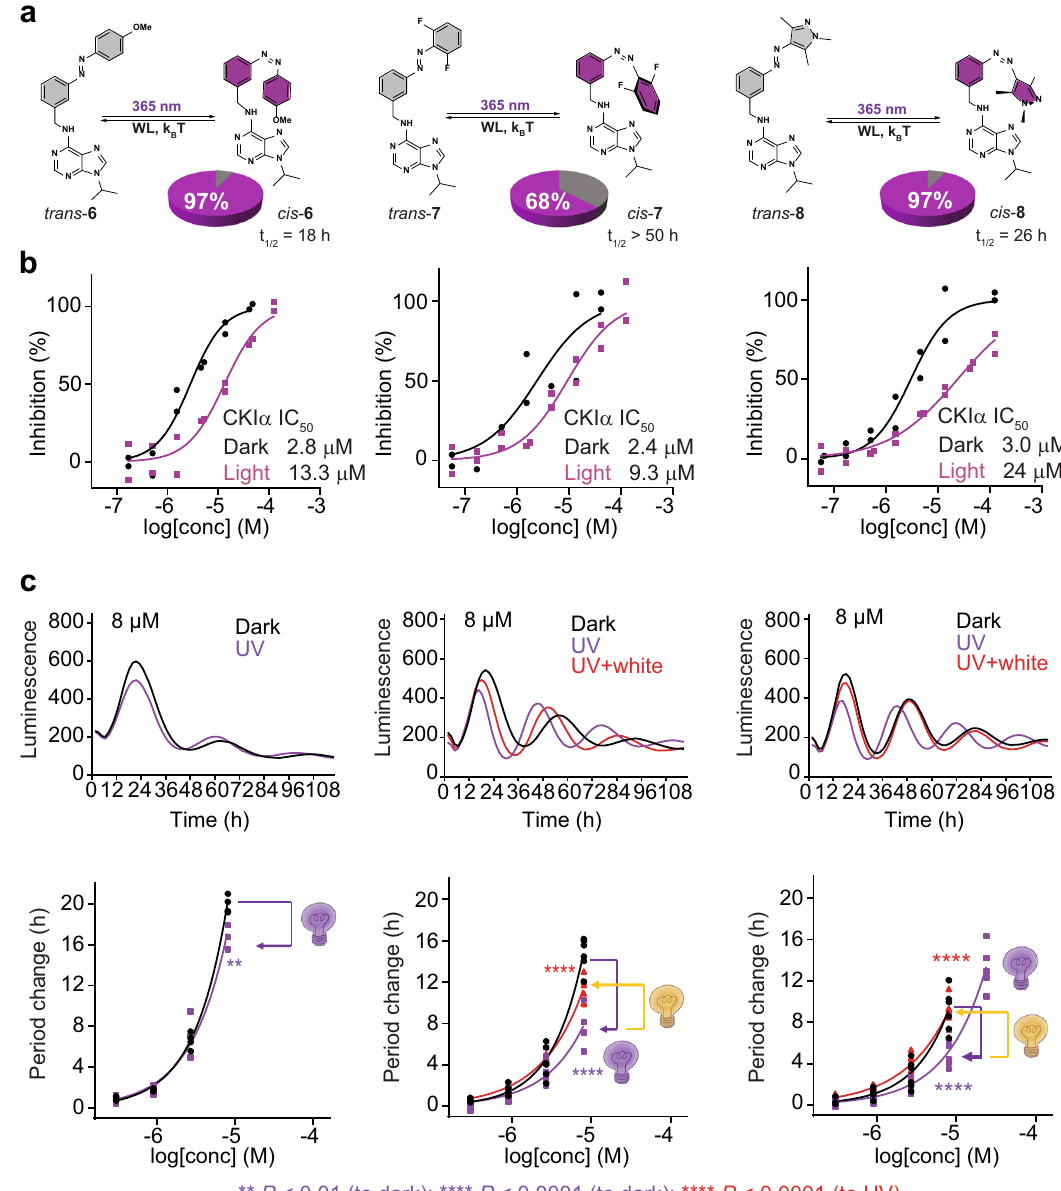
Fig. 3 Photochemical and biological evaluation of modulators 6-8. a Chemical structures of 6 - 8 , photochemical trans -to- cis isomerization (UV light, λ = 365 nm), thermal- or white- light- induced back-isomerization and corresponding percentage of cis isomer (pie chart, purple) that can be generated max under irradiation at PSS and thermal half-lives of modi fi ers 6 , 7 , and 8 in cell culture medium (40 µ M, 35 °C). Upon reaching PSS distribution under UV light irradiation, thermal back-isomerization was followed in dark for 12 – 14 h. b Kinase (CKI α ) and c cellular (U2OS cells) assay data for modulators 6 - 8 . Dose-response curves of the kinase inhibition or the circadian period lengthening under the dark condition are shown in black, upon irradiation with UV light in purple, and back-switching with white light is indicated with red lines. Effects of dark, UV light (purple bulb), and UV light followed by white light (yellow bulb) conditions on luminescence rhythm pro fi les (average of n = 6) are also shown in the top panels of c (8 µ M of each inhibitor). Data for longdaysin- and DMSO-treated cells are shown in Supplementary Fig. 24c, d, respectively. Luminescence is given in arbitrary units. n = 2 biologically independent samples for the enzymatic assay ( b ), and n = 4 – 6 biologically independent samples for the cellular assay ( c ). Two-way ANOVA followed by a Sidak ’ s multiple comparisons test was used for statistical analysis. P value is shown in the fi